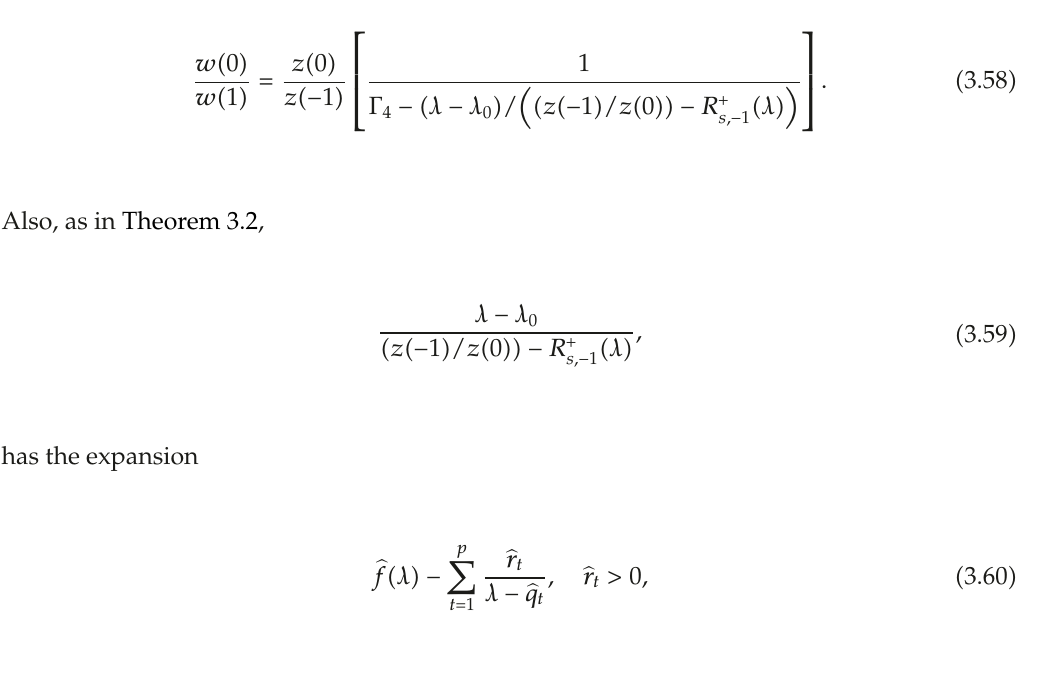
(cid:2) λ (cid:3) s, − 1